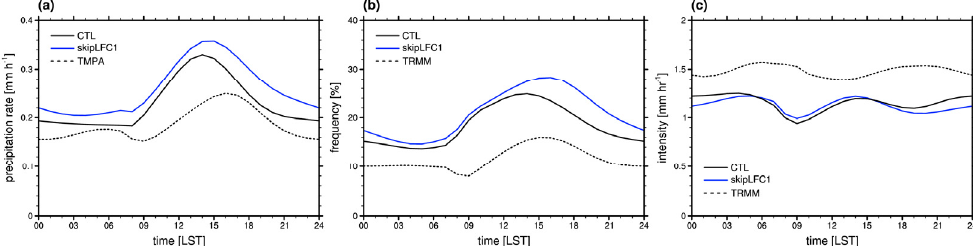
Figure 7. Diurnal variations of ( a ) precipitation rate (mm h − 1 ), ( b ) precipitation frequency (%), and ( c ) precipitation intensity per precipitation occurrence (mm h − 1 ) averaged for JJA 2006 over the East Asian land area from the TMPA observation (dashed lines) and skipLFC1 experiment (blue solid lines). The result of the CTL experiment is also plotted for comparison as a black solid line.